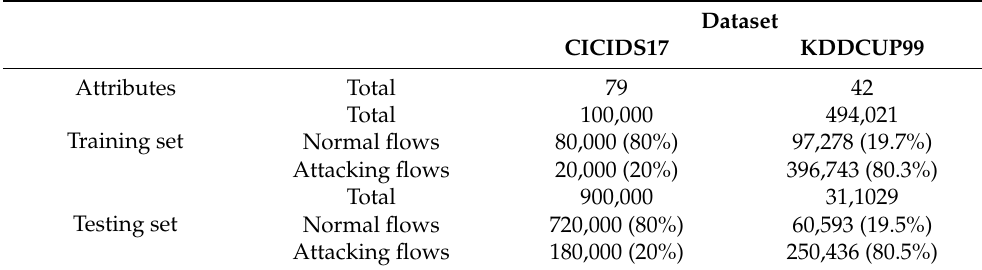
Table 3. Description of the data set.